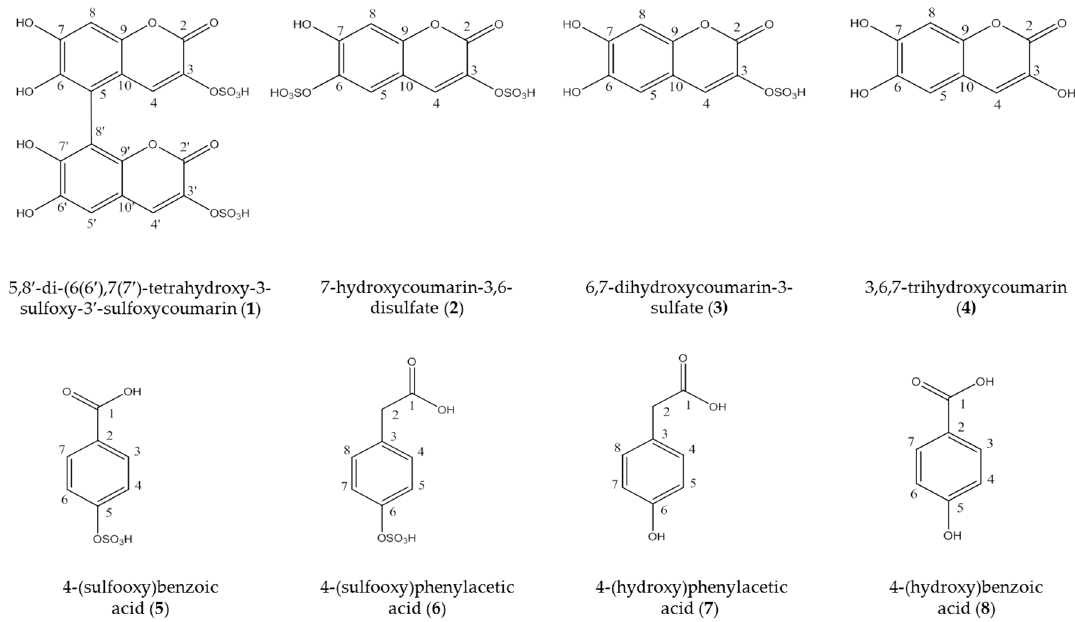
Figure 1. Chemical structure of the isolated coumarins from the marine green alga Dasycladus vermicularis , the sulfated phenolic acids and their educts.